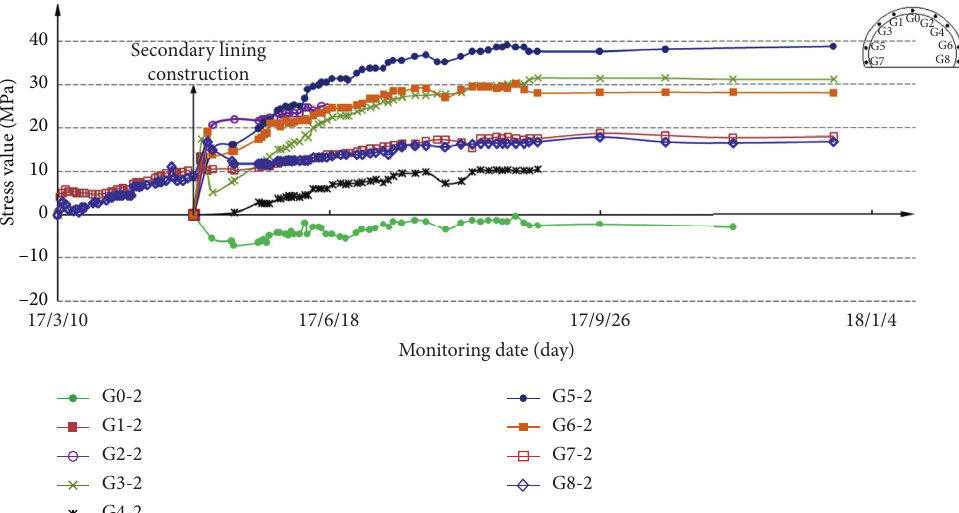
Figure 15: Stress temporal curves of inner side steel bar in secondary lining at section YK2+449.